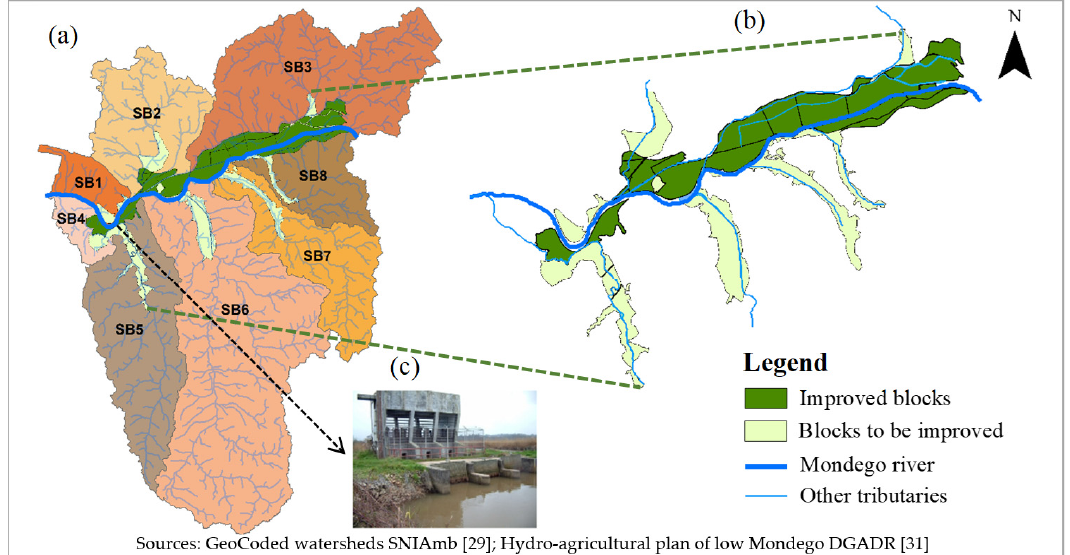
Figure 2. Low Mondego divided into sub-basins ( a ), blocks of agricultural land in Low Mondego ( b ), Pranto structure ( c ) [29,31].